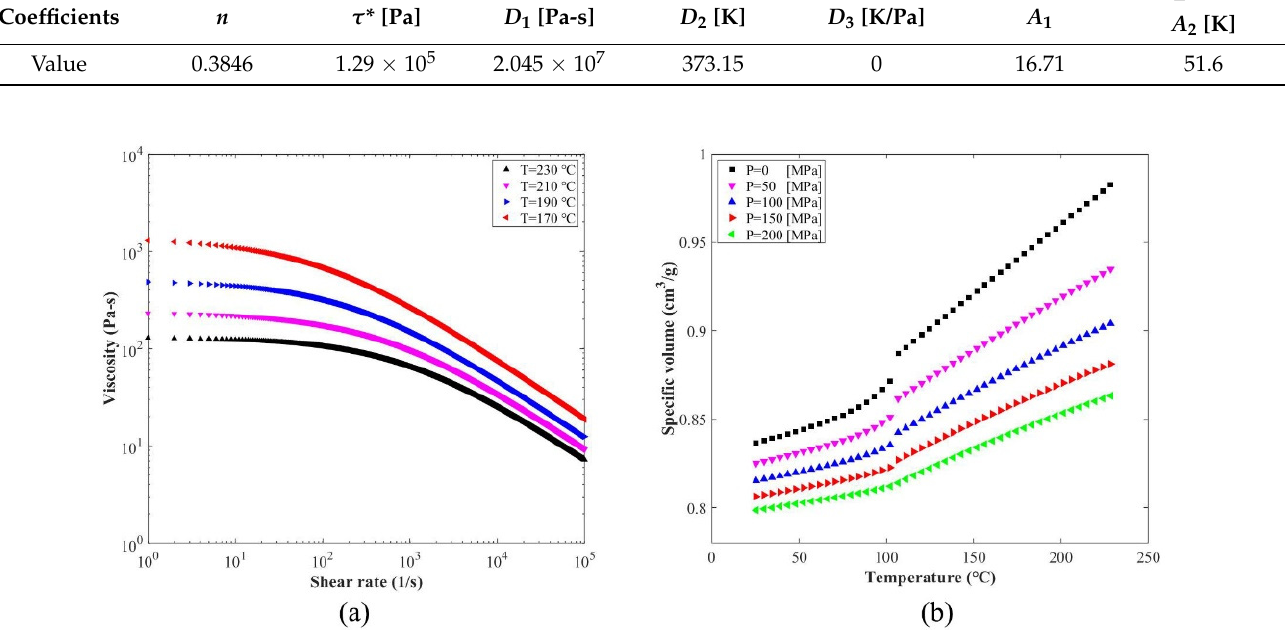
Figure 2. Viscosity and material state curves for PLA 3251D. ( a ) Cross-WLF viscosity model; ( b ) the modified 2-domain Tait pvT